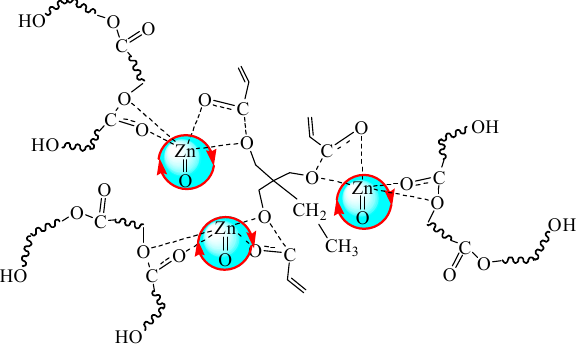
Figure 5. Schematic diagram of the coordination effect of nano-ZnO with PLA chains and the monomer TMPTA.